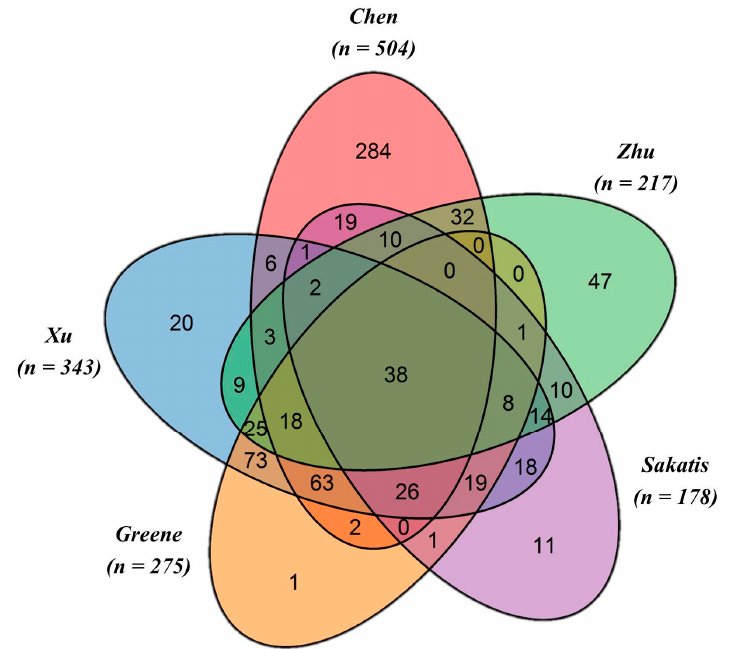
Figure 1. Venn diagram showing the commonality and specificities among the five individually annotated datasets. Among the different authors, a total of 38 drugs were commonly annotated. Highlighted in the Venn diagram are also specific data sets. For example, the Zhu et al. dataset contains n = 47 drugs uniquely annotated by these authors. Similarly, n = 11 unique drugs are considered in the Sakatis et al. data set. The R package VennDiagram [18] was used to generate this figure.